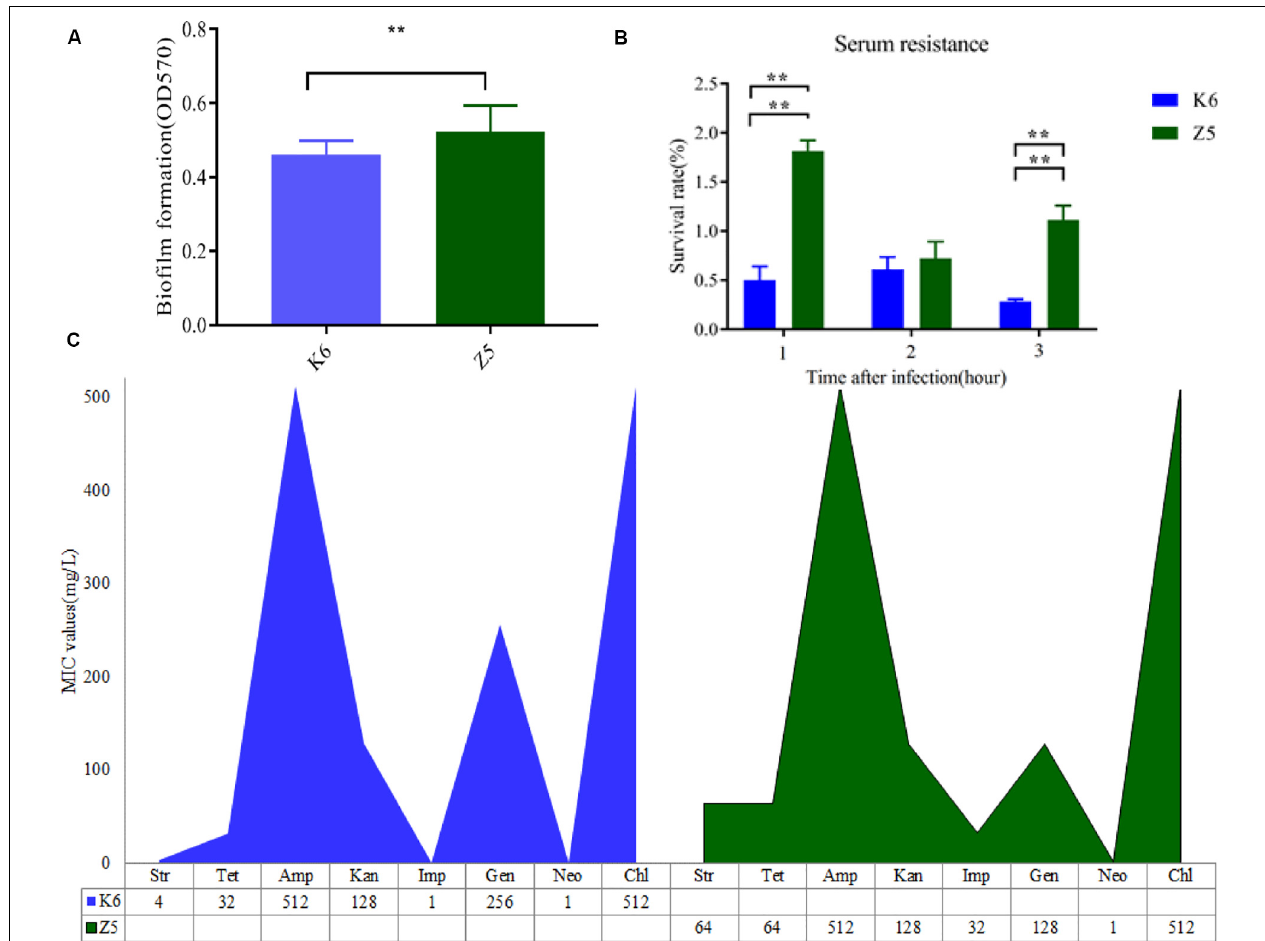
FIGURE 2 | Virulence potential and antibiotic resistance profiles of K. variicola Z5 and K6. (A) Biofilm formation quantified by crystal violet staining and analysis at OD 570 ( n = 3). (B) Human serum resistance assays were performed using healthy human serum to assess the survival rate of 1 × 10 6 colony-forming units of each strain after 3 h ( n = 3). (C) Antibiotic resistance characteristics of all strains using CLSI antimicrobial susceptibility testing standards (Clinical and Laboratory Standards Institute [CLSI], 2009). The different colors represent different strains, with the height of the column indicating the MIC value of the corresponding antibiotic ( n = 3). Data presented as means ± SD ( n = 3), difference at significance level * P < 0.05, **P < 0.01 ( t -test) between two